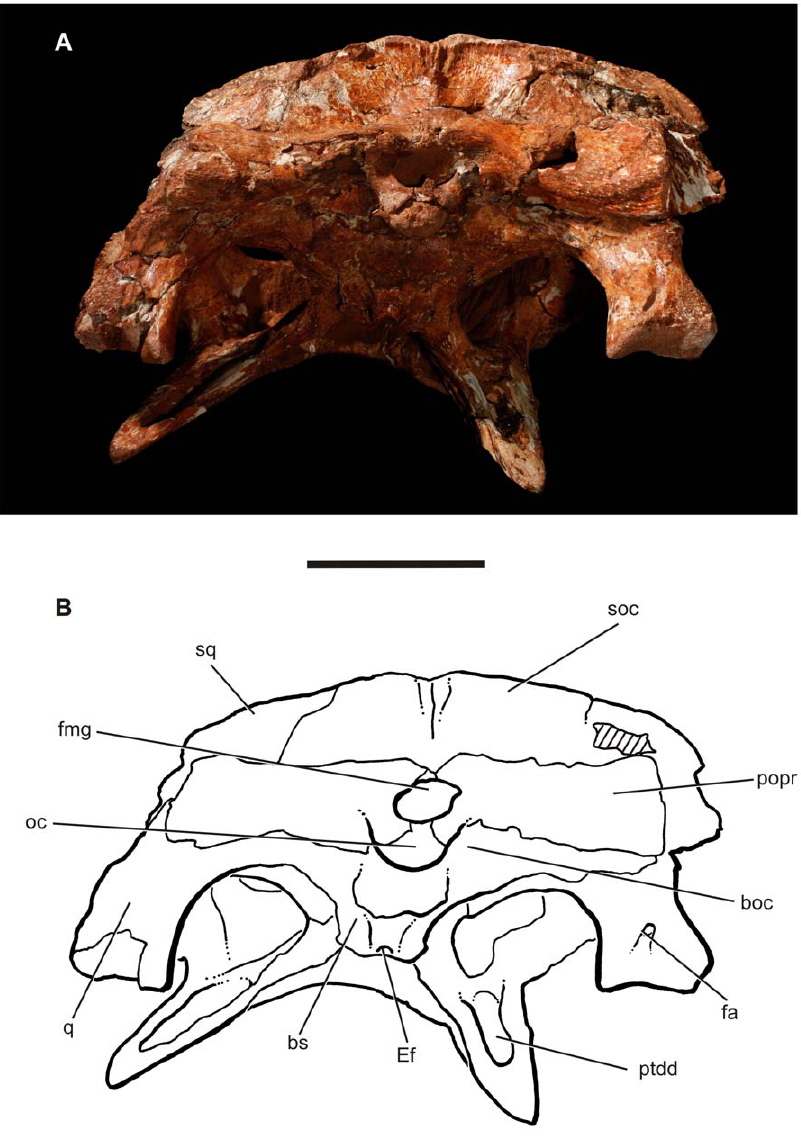
Figure 5. Skull of the baurusuchid Pissarrachampsasera (LPRP/USP 0019, holotype). A) occipital view; B) interpretive drawing of the occipital view. Abbreviations: boc, basioccipital; fa, foramen ae¨rum; ptdd, pterygoid dorsal depression. Scale bar equals 5 cm.